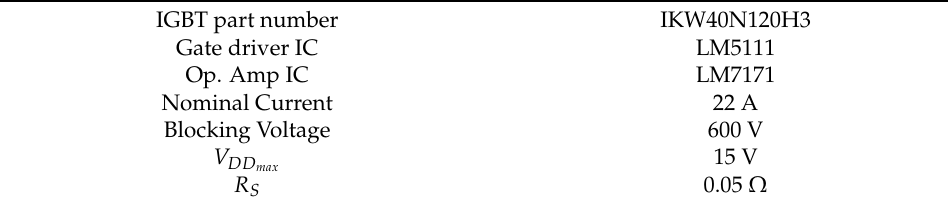
Figure 10. IGBT I SC and V GE waveforms for a sustained SCF condition. Table 3. The specifications of the considered case for